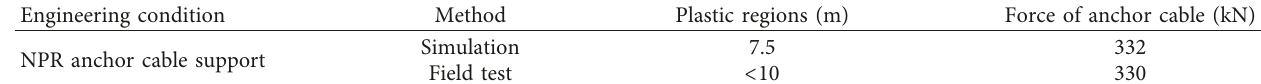
Table 3: Comparison of numerical simulation and field test.